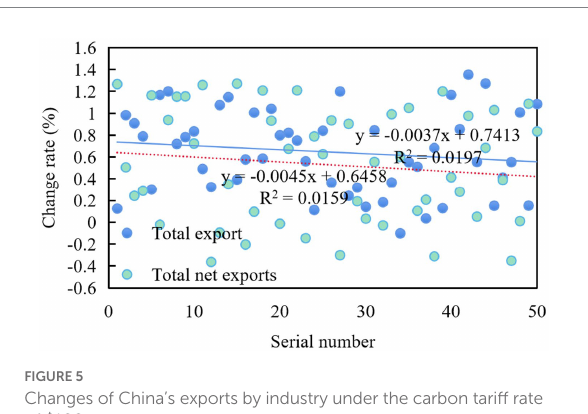
FIGURE 5 Changes of China’s exports by industry under the carbon tariff rate of